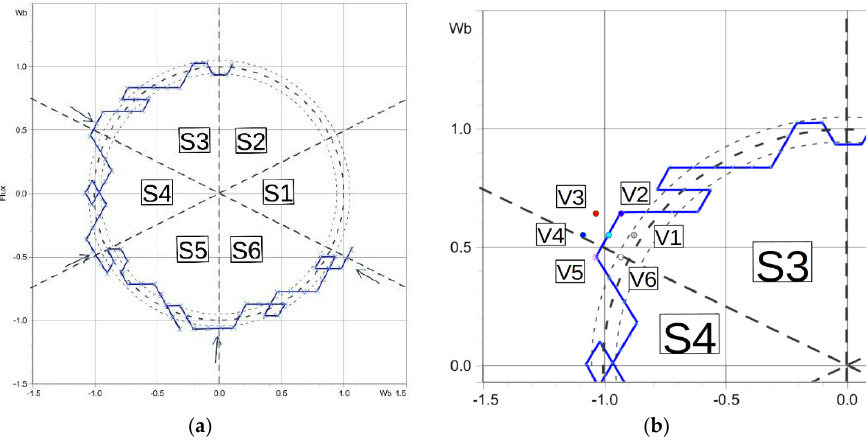
Figure 6. ( a ) The part of the flux vector tip trajectory at DTC run. The flux sector transition is marked by arrows. ( b ) The detail of the transition. The voltage vector V5 is applied according to the Table 1. This vector increases the flux level instead of decreasing it.